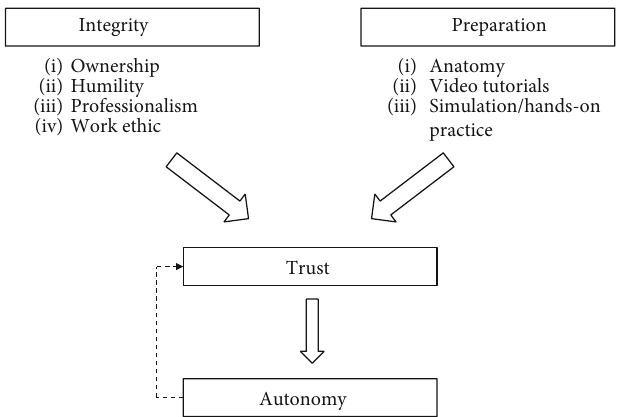
Figure 6: Flow chart of our proposed process towards surgical autonomy for